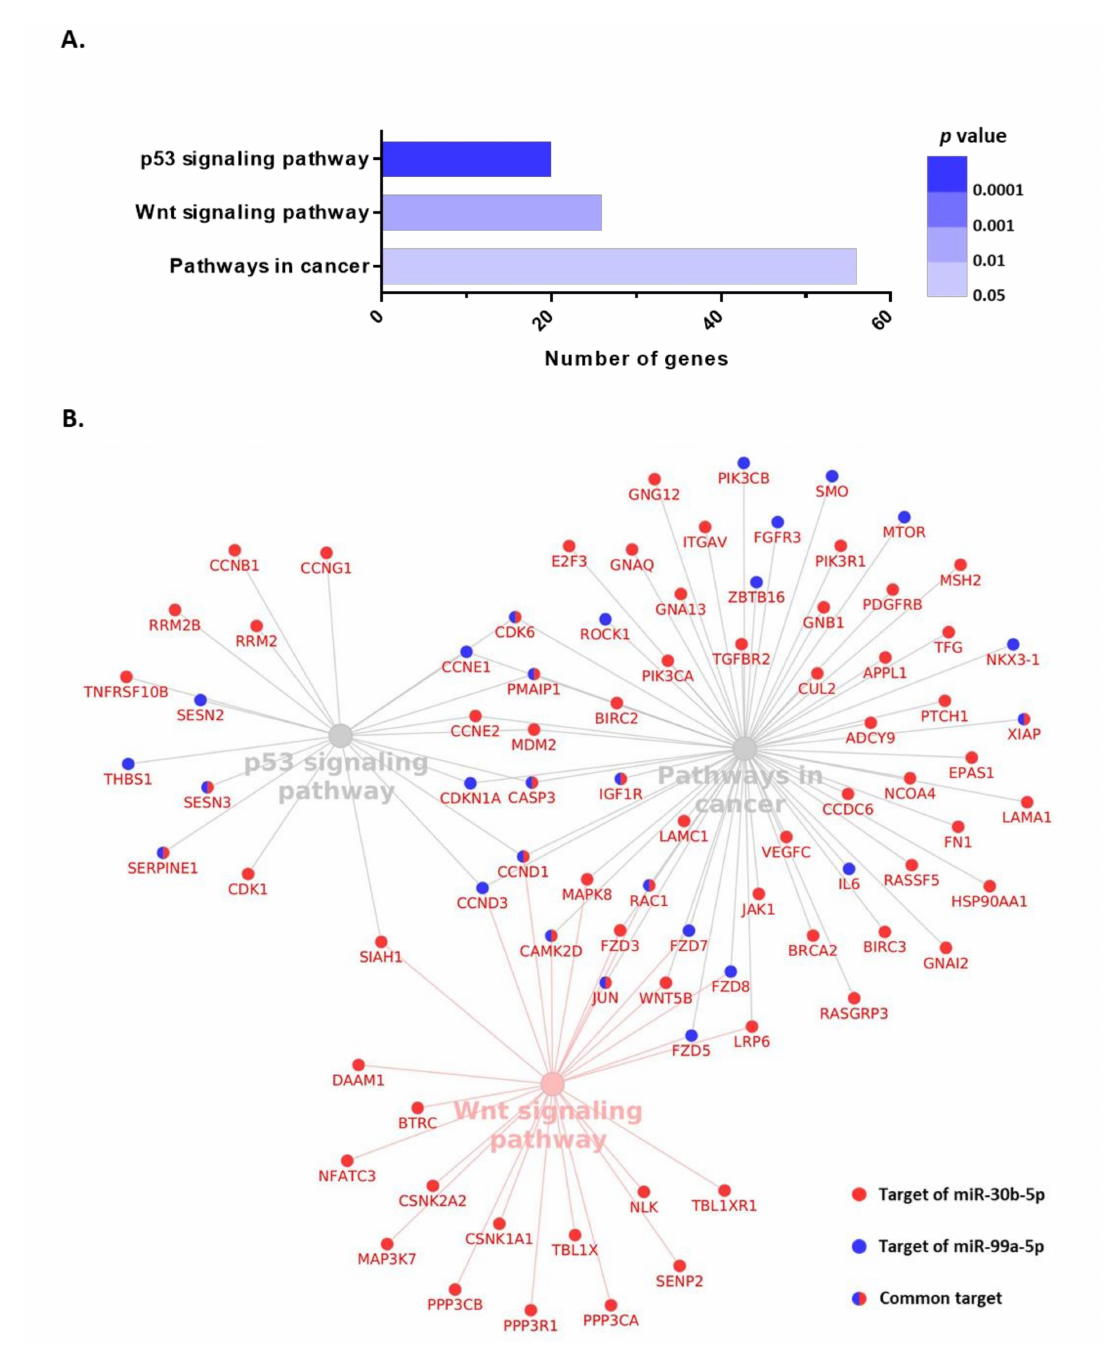
Figure 6. KEGG pathway enrichment analysis of miR-30b-5p and miR-99a-5p using DIANA Tools MirPath v3.0. ( A ) Significantly enriched pathways. ( B ) Interaction between miRNAs and their predicted target